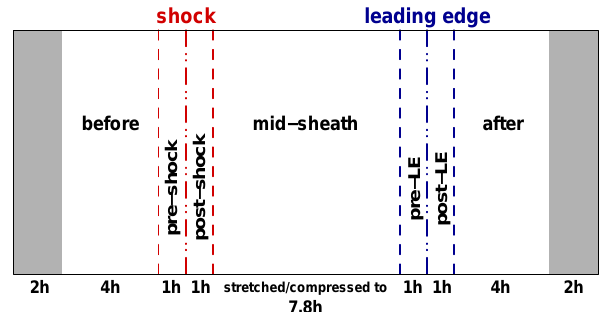
2005; Kessel et al., 2004; Kessel, 2010; Simms et al., 2008).